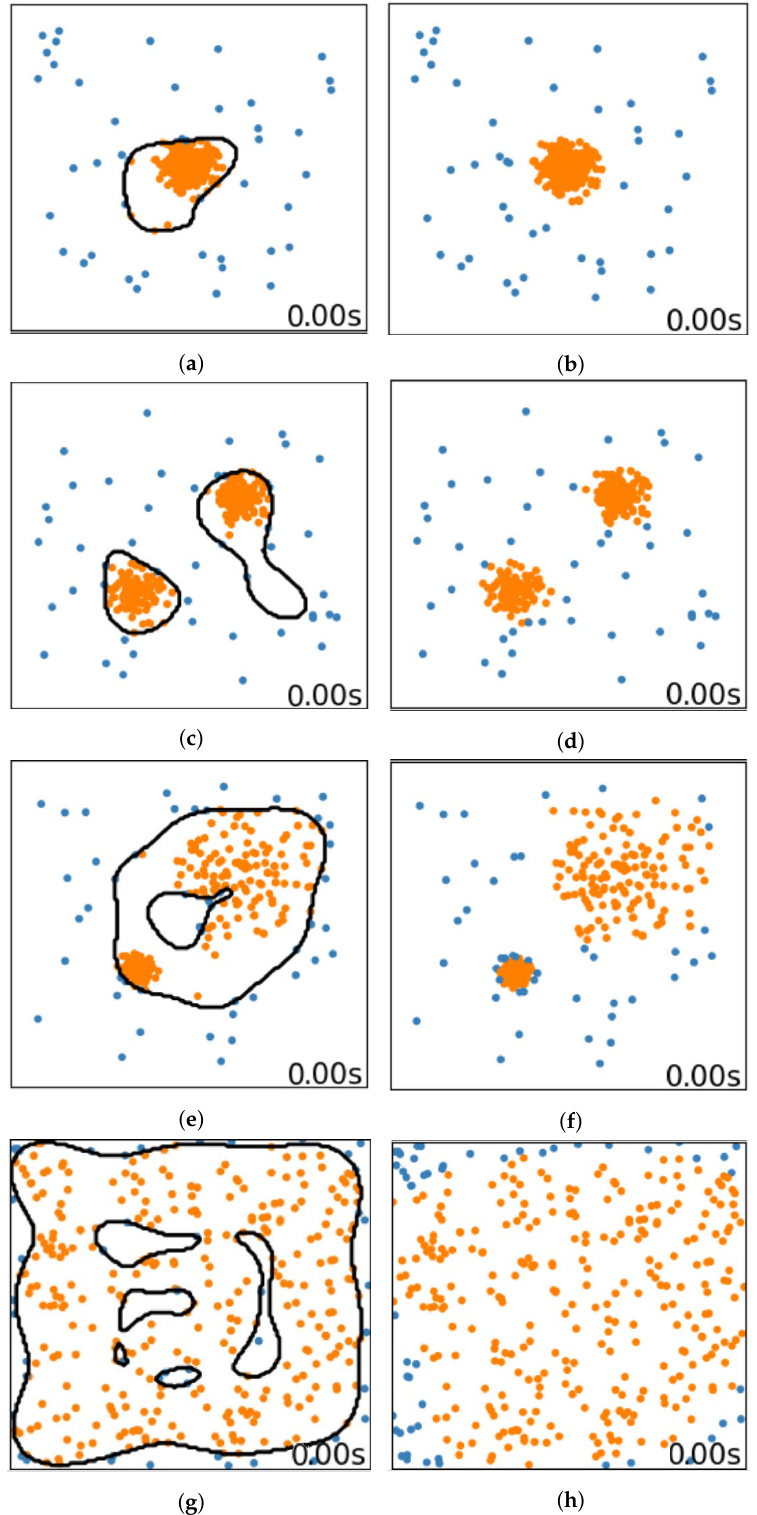
Figure 2. Comparison between two methods of outlier detection. The images used were first presented in [69]. ( a ) SVM one class-case #1; ( b ) LOF-case #1; ( c ) SVM one class-case #2; ( d ) LOF-case #2; ( e ) SVM one class-case #3; ( f ) LOF-case #3; ( g ) SVM one class-case #4; ( h ) LOF-case